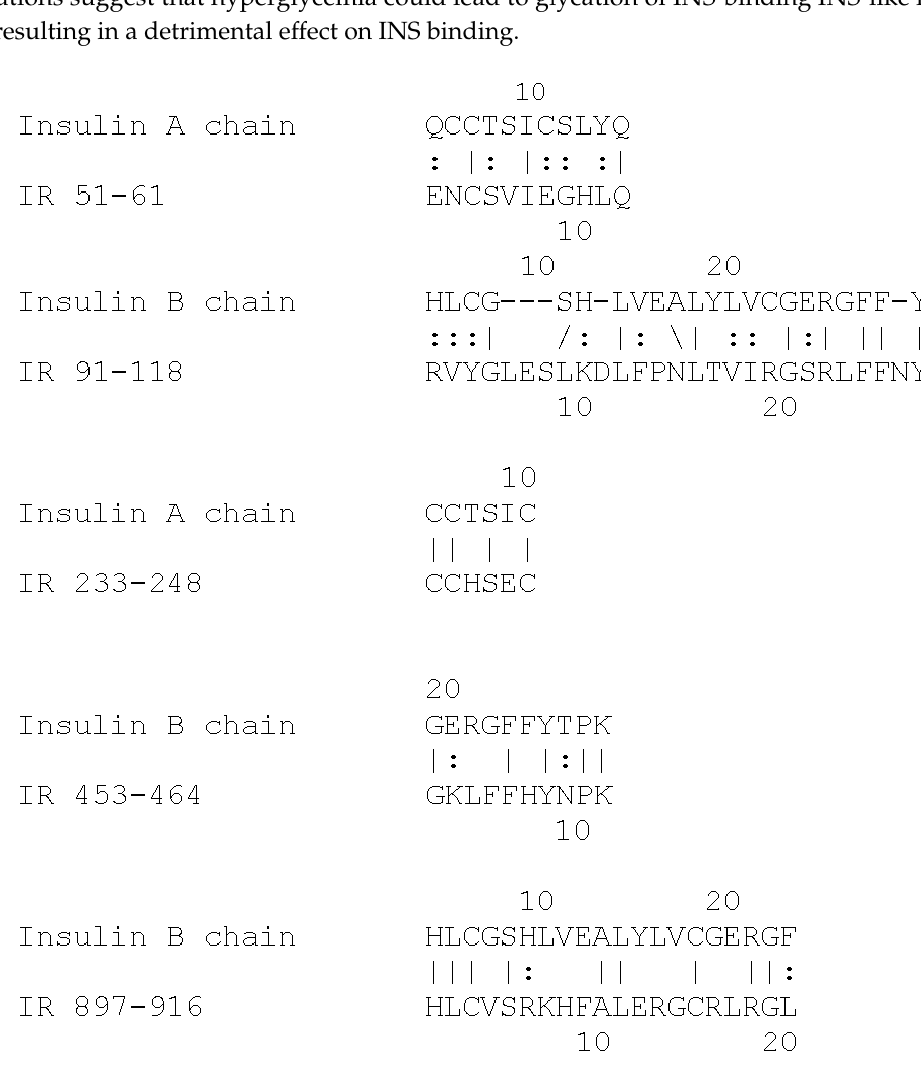
Figure 1. Insulin homologies in the human insulin receptor (IR). Lines indicate identical amino acids; dots indicate conserved amino acid substitutions.